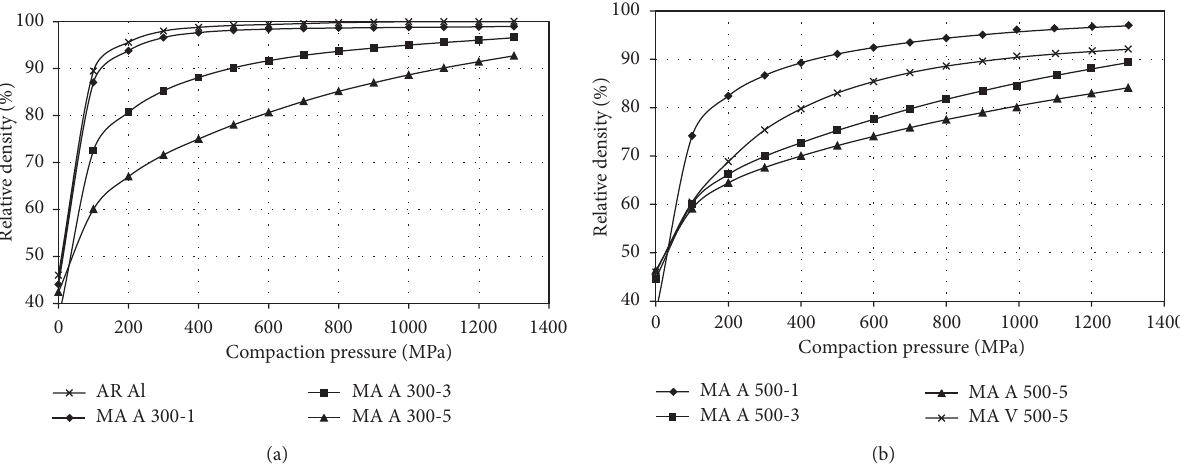
Figure 4: Compressibility curves of (a) ARAl and powders milled in ammonia at 300rpm for 1, 3, and 5 h and (b) powders milled at 500rpm in vacuum for 5 h and in ammonia for 1, 3, and